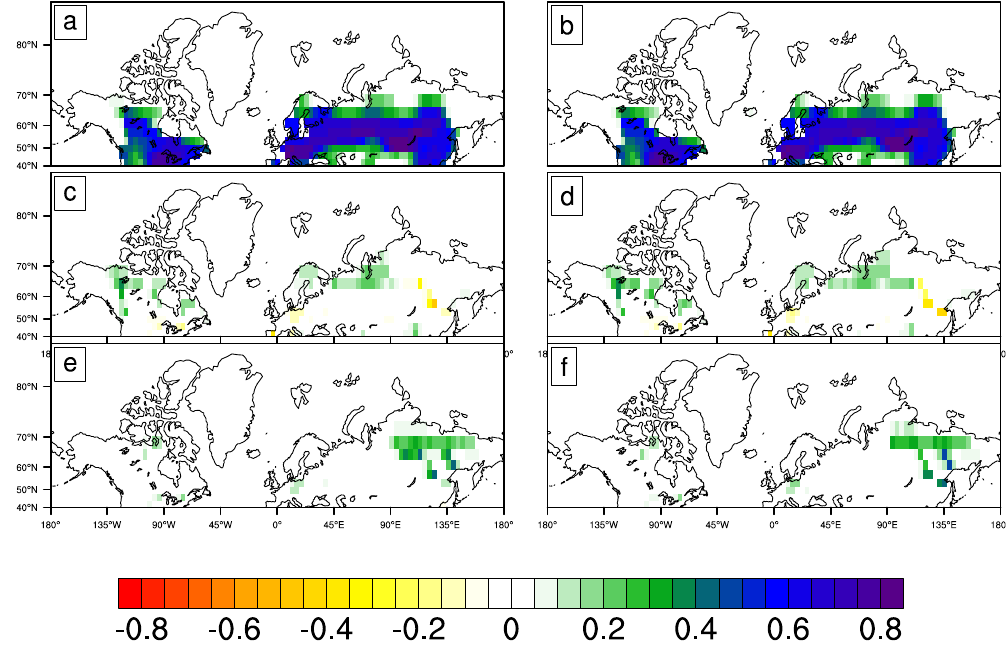
Fig. 3. Forest cover for the two sets of simulations with weak snow masking (left column) and strong snow masking (right column). The upper two panels (a) and (b) give the total forest cover for present day climate – (a) =0k(AV) w and (b) =0k(AV) s . The panels (c) and (d) show the change in evergreen forest – (c) =6k(AV) w –0k(AV) w , (d) =6k(AV) s –0k(AV) s ; the panels (e) and (f) for deciduous forest – (e) =6k(AV) w –0k(AV) w , (f) =6k(AV) s –0k(AV) s